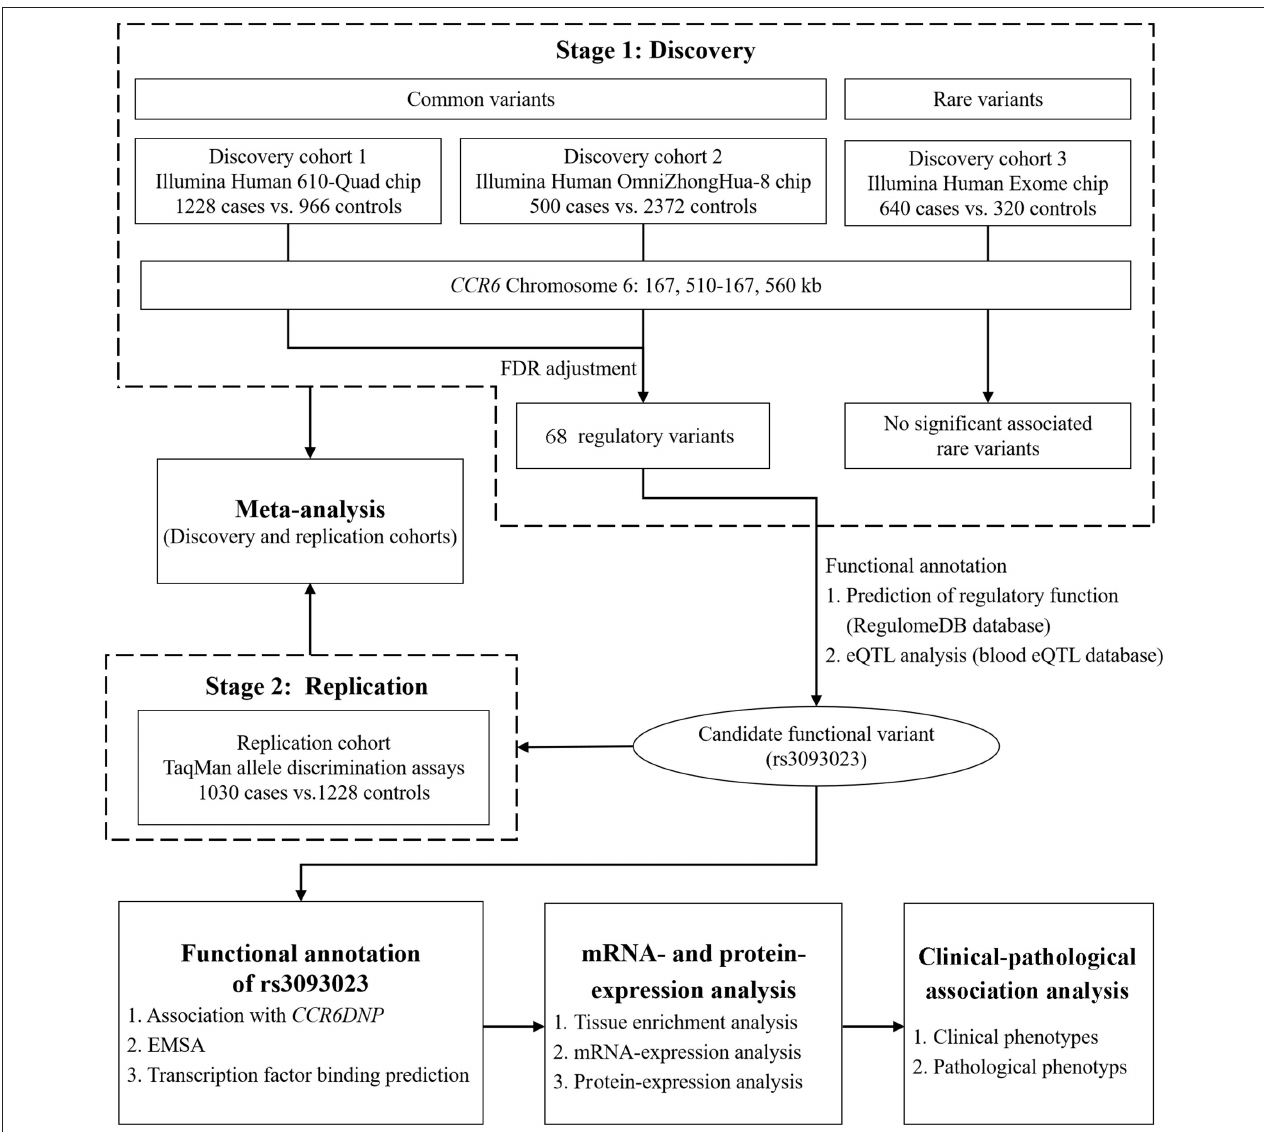
FIGURE 1 | Flowchart of the study design. In the discovery stage, we conducted a genetic association study between the CCR6 common and rare variants and IgAN using multi-platform chips. The replication stage was aimed at replicating the functional loci discovered in the discovery stage using an independent population. After the two-stage genetic association analysis, we conducted in silico functional prediction, expression association analysis, and clinical-pathological association analysis.